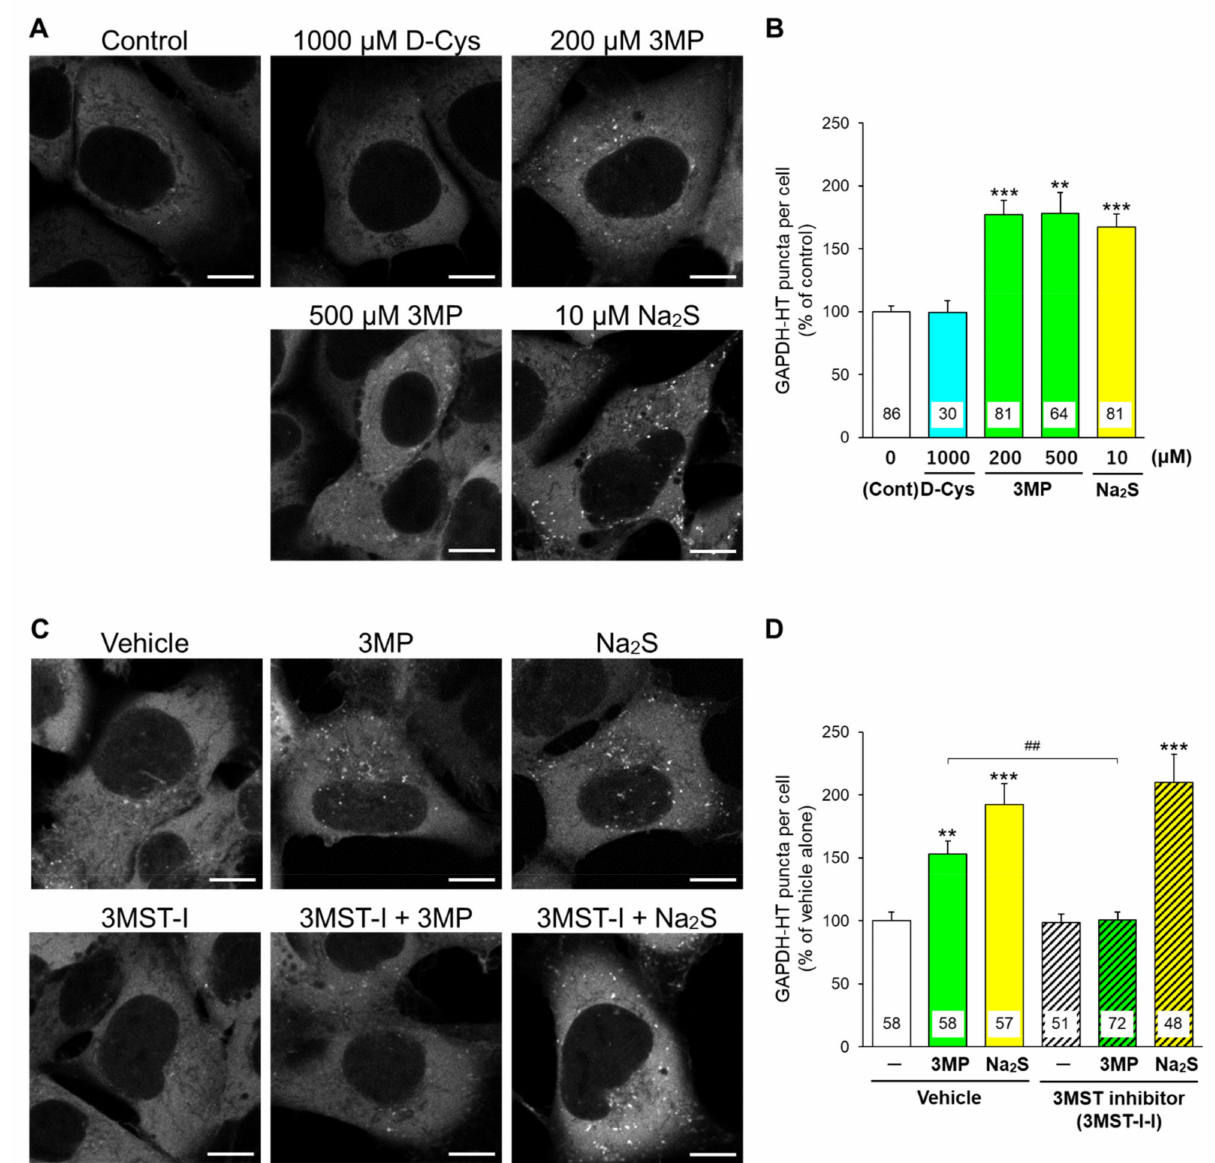
Figure 3. Effects of D-cysteine, 3MP, and Na 2 S on CMA/mA activity in AD293 cells stably expressing GAPDH-HT. ( A ) Punctate accumulation of GAPDH-HT in AD293 cells treated with D-cysteine (1000 µ M), 3MP (200 and 500 µ M), and Na 2 S (10 µ M) for 24 h. Control refers to cells without treatment. ( B ) Quantitative analyses of GAPDH-HT puncta shown in A. ( C ) Punctate accumulation of GAPDH-HT in AD293 cells treated with 3MP (200 µ M) and Na 2 S (10 µ M) in the presence of a vehicle (0.1% dimethyl sulfoxide or 3MST inhibitor (3MST-I, 100 µ M) for 24 h. ( D ) Quantitative analyses of GAPDH-HT puncta shown in C. Scale bars = 10 µ m. Numbers in the columns represent the numbers of observed cells. ** p < 0.01, *** p < 0.001 vs. control or vehicle alone, ## p < 0.01 (Dunn’s multiple comparisons